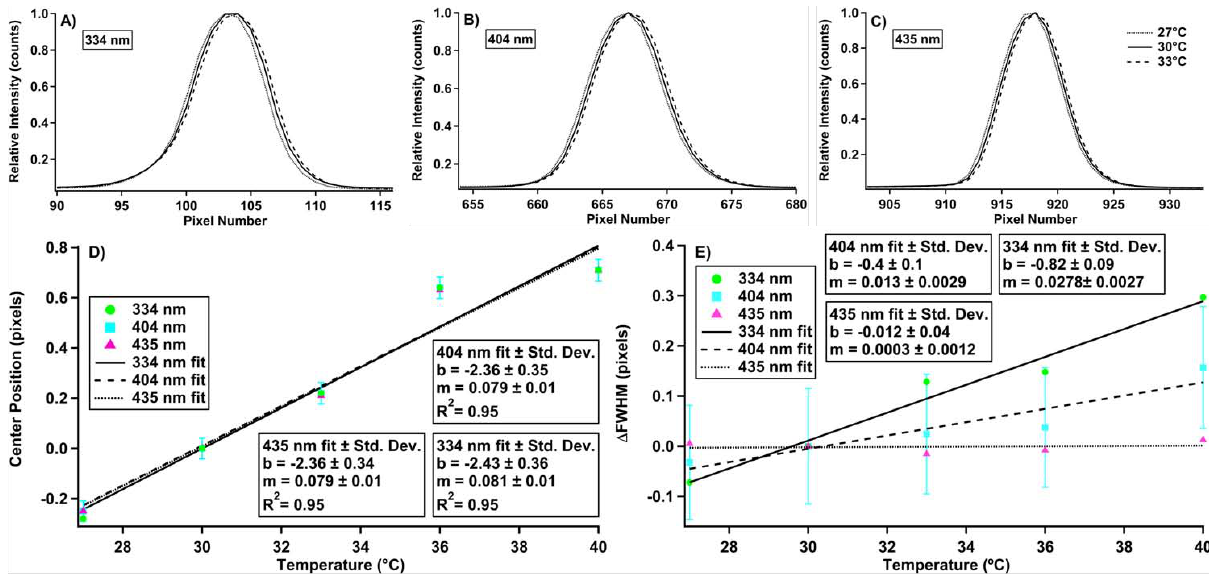
Fig. 2. Characterization of the spectrometer/detector system with respect to temperature changes. (A–C) Spectral line shape as a function of temperature for 334nm, 404nm, and 435nm, atomic emission lines of an Hg-Ar lamp. (D) Spectral shift of atomic lines as a function of temperature. (E) Difference in the full width at half the maximum of the line shapes as a function of temperature.